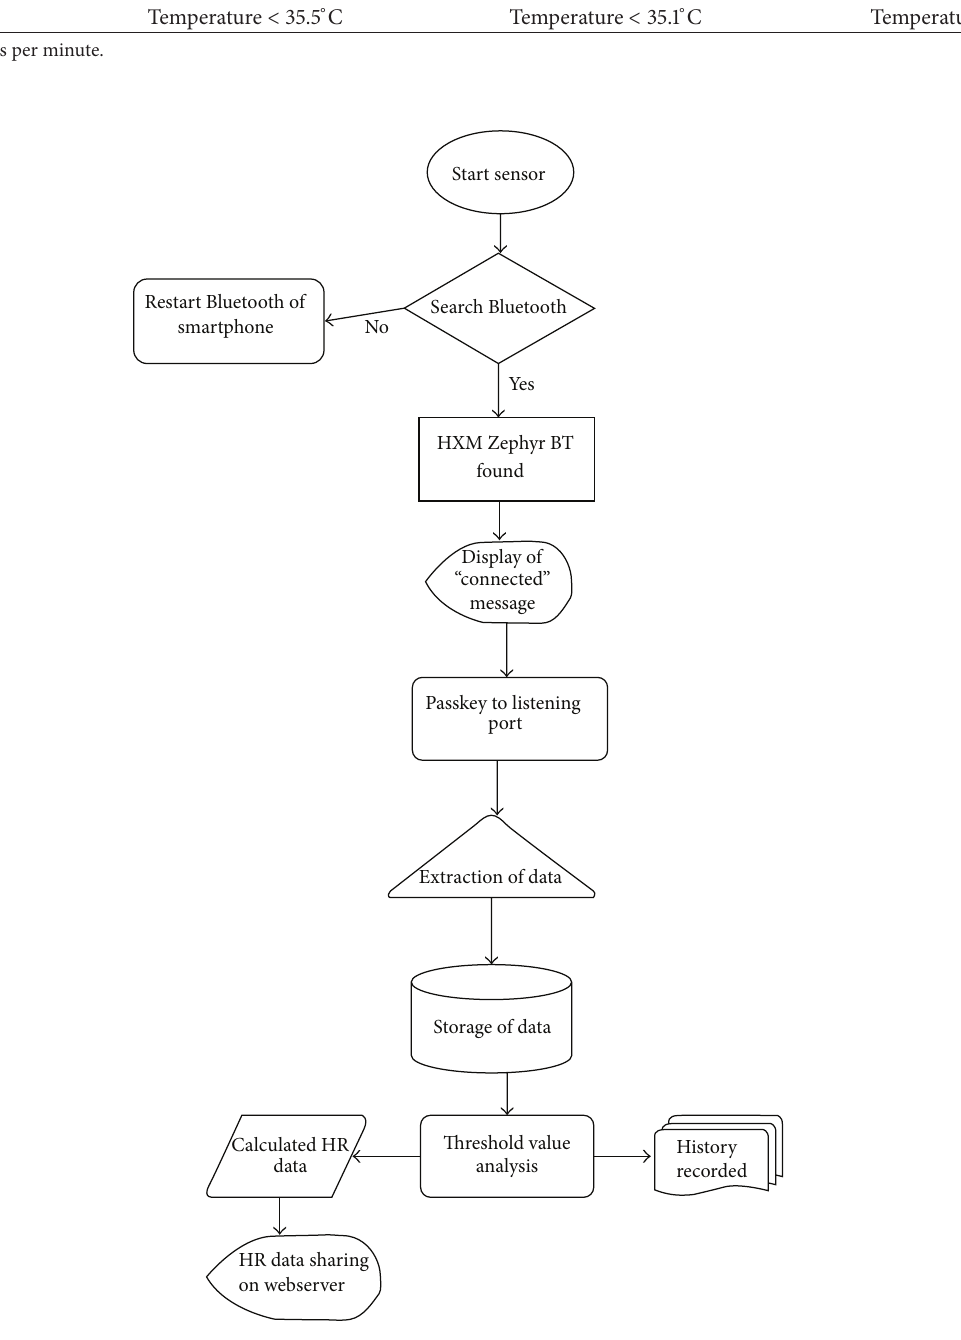
Figure 7: Flowchart of the remote patient monitoring